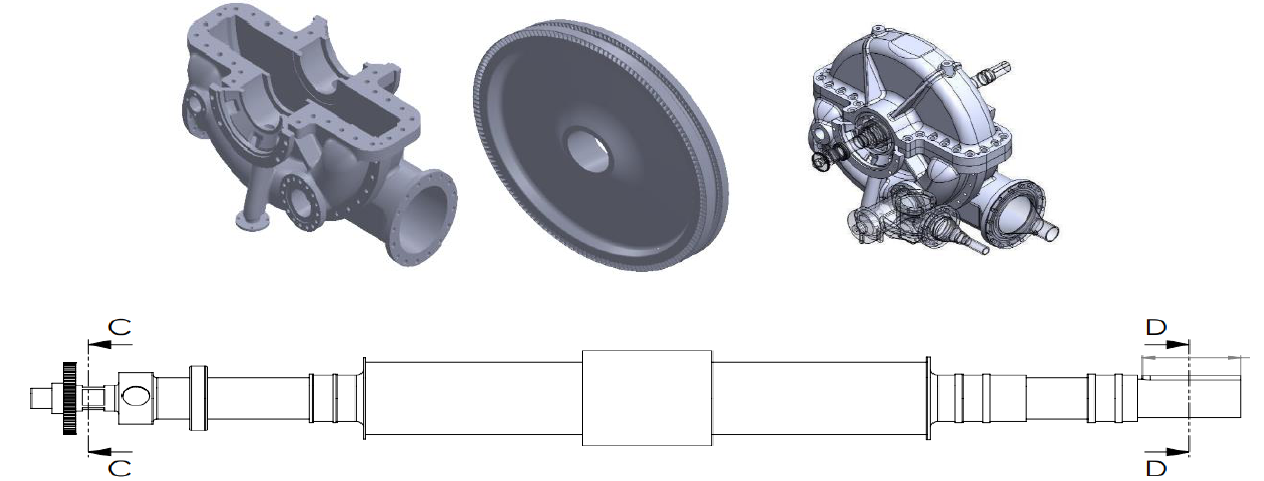
Figure 6. Components of axle shaft and propeller.